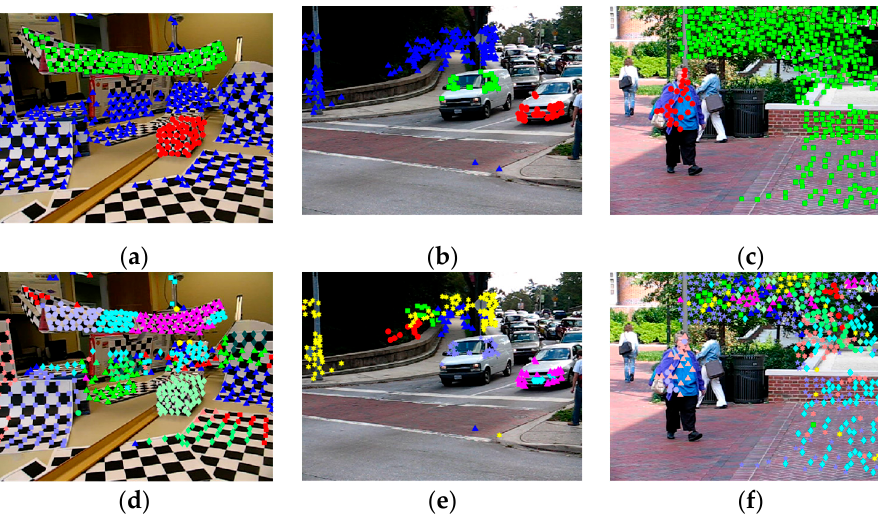
Figure 1. Some data grouping results in video sequences of the Hopkins 155 dataset. Top ( a , b , c ): Ground truth for the checkerboard sequence 2RT3RCT_B, the traffic sequence cars9, and the articulated sequence people2, respectively, where the data points belonging to different motion models are labeled with different colors. Bottom ( d , e , f ): The corresponding data point grouping results. We obtain many data clusters and points in the same cluster almost always belong to the same motion mode.